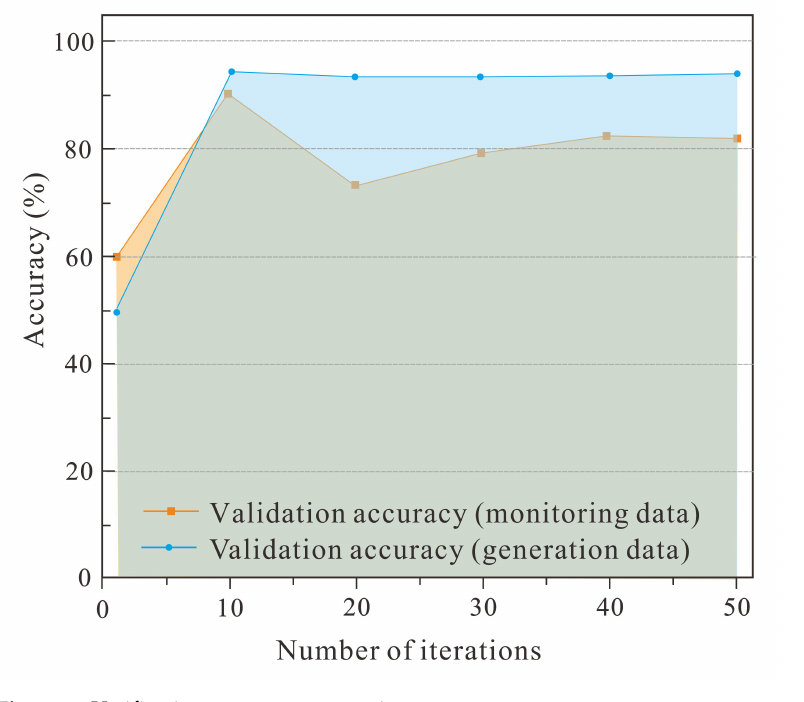
Figure 8. Verification accuracy comparison.